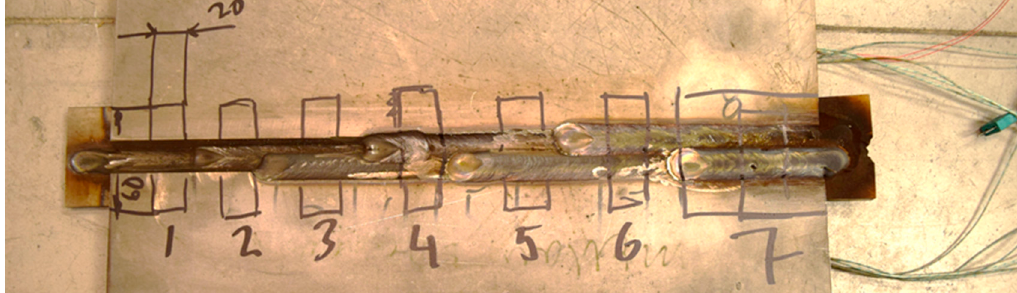
Figure 2. Welding configuration used to extract coupons to study the evolution of the microstructure caused by the subsequent weld passes. The numbers from 1 to 7 correspond to the locations where coupons with passes from 1 to 7 were extracted and contained that number of weld passes, i.e., 1 means one weld pass, 2 means two weld passes, and so forth until 7, including the seven weld passes in the GH weldment.